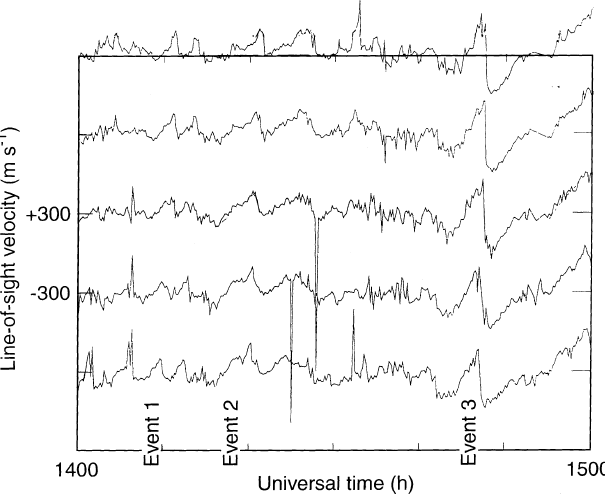
Fig. 3. Five contiguous ranges of the line-of-sight velocity for the interval 1400–1500 UT on 5 February 1994. The three events marked are studied in further detail, together with the rapid fall in velocity immediately following event 3. There are two very large negative velocity spikes at 1425 and 1428 UT. We believe that these are caused by interference, and are not geophysically significant.